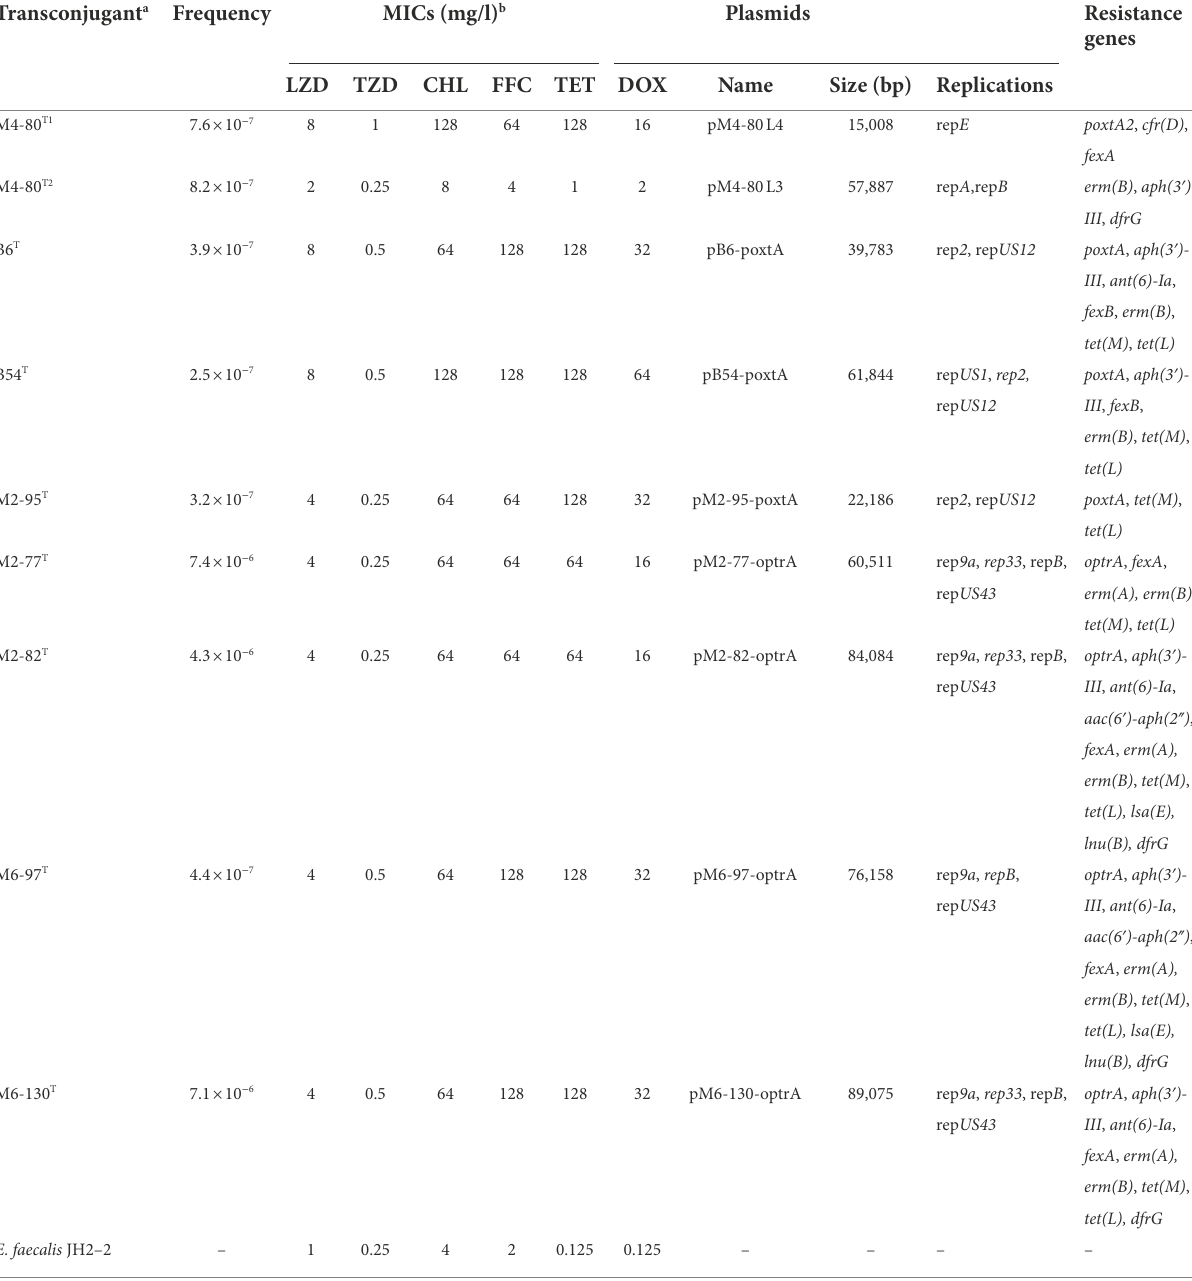
TABLE 2 Information of the different plasmids harboring transferable oxazolidinone resistance genes and antimicrobial susceptibilities of the transconjugants and recipient isolates. Transconjugant a